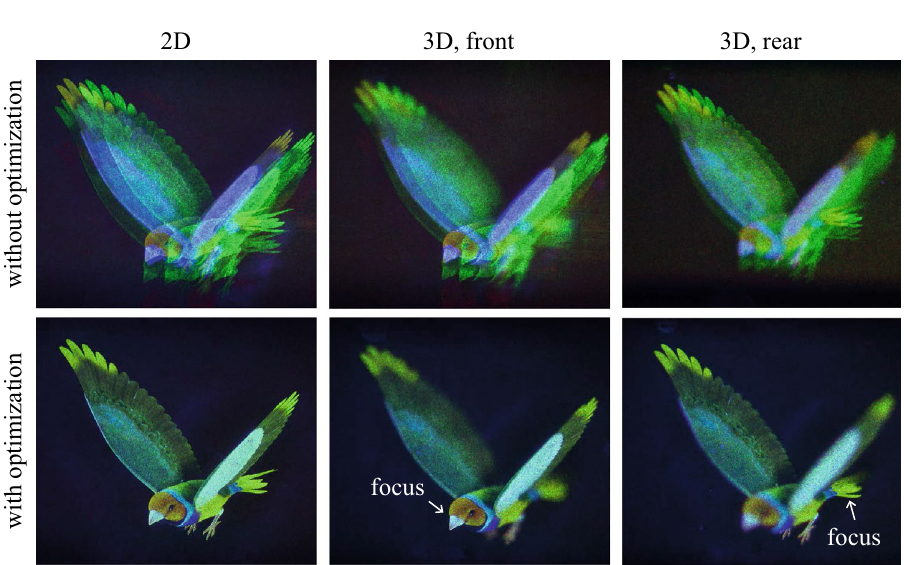
Figure 4. Full color finch images observed from the center viewpoint of the exit-pupil. A 2D finch image and 3D images with focus on the front and rear are reconstructed with and without CGH optimization. The finch image is purchased from TurboSquid, All Rights